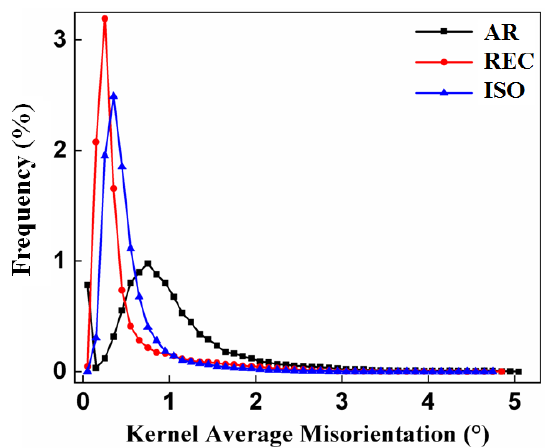
Figure 13. Quantitative distribution of the misorientation levels in the samples.